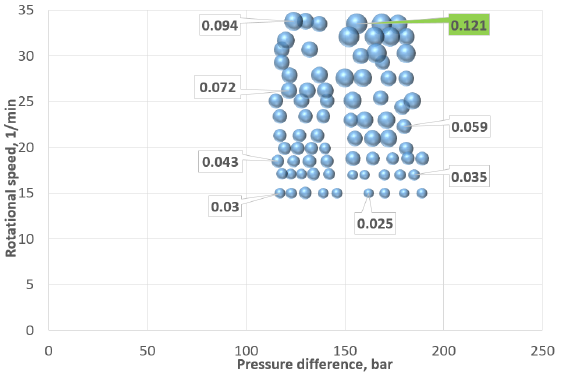
Figure 12. Total efficiency (value in label) of the modified hydraulic motor, with hole size in valve plate φ = 5.5mm, tested in water.